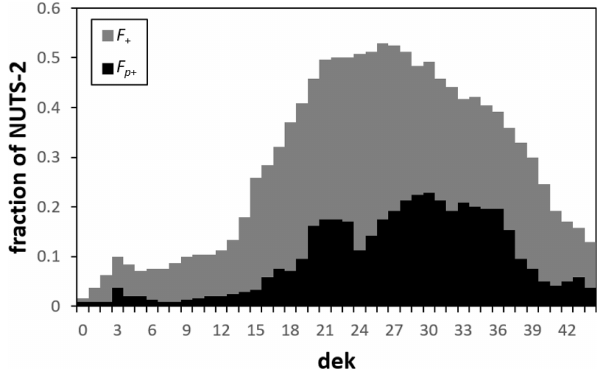
Figure 4. Fraction of NUTS 2 regions for which each dekad is in- cluded in the longest homogeneous period with F p + = 1 (black) or F + = 1